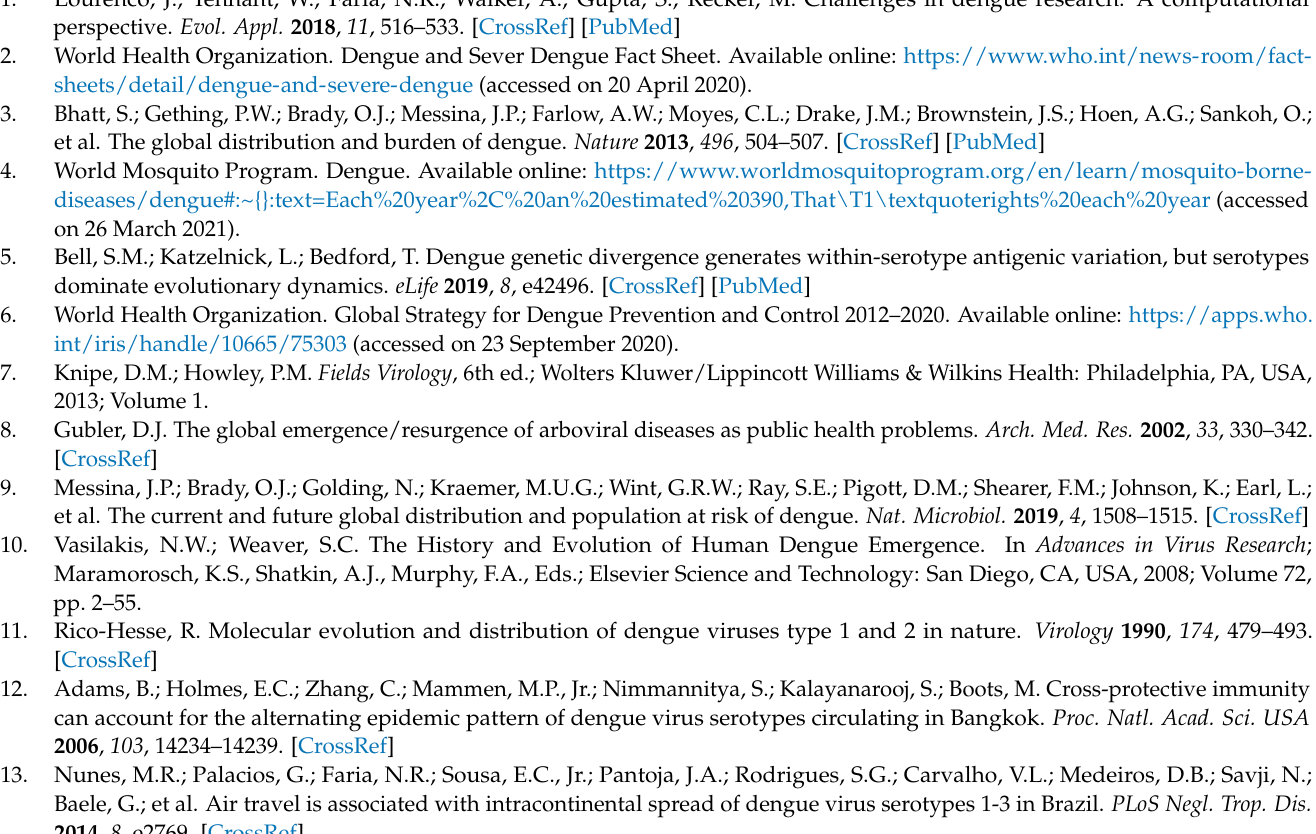
Figure S15: DENV4 MCMC tree—Whole Genome Genotypes; Figure S16: DENV4 MCMC tree—Envelope Gene; Table S3: Evolutionary Rates pre- and post-1990; Table S4: Episodic Site-Specific Positive Selection; Table S5: Branch Specific Positive